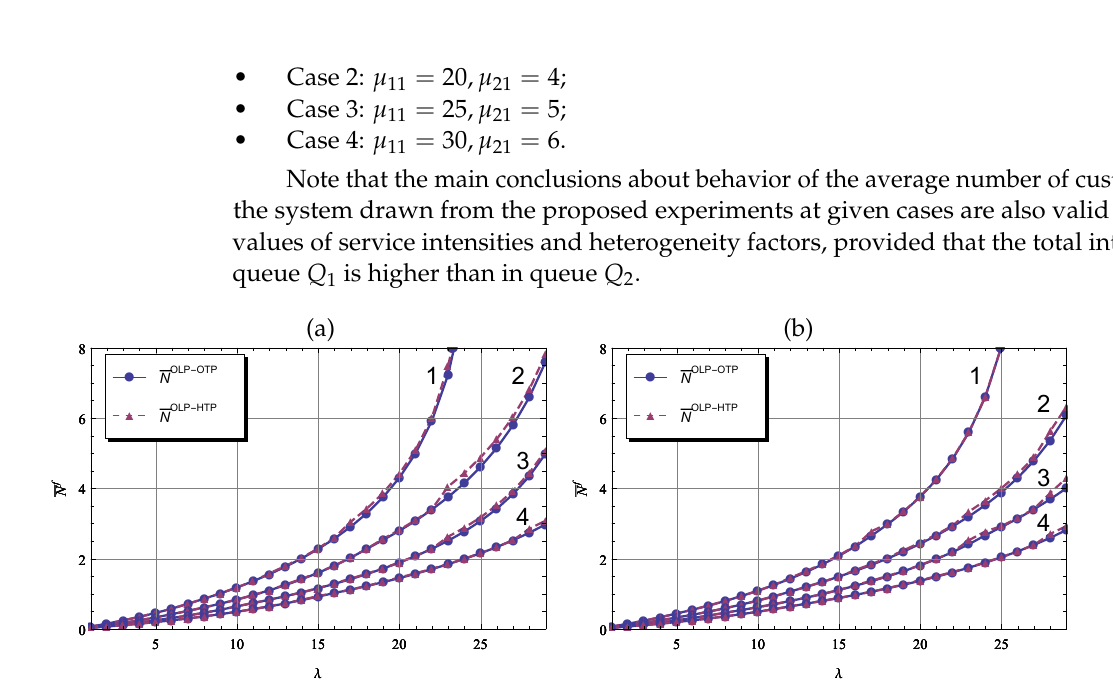
Figure 2. ¯ N f for µ 12 = 10, µ 22 = 2 ( a ) and for µ 12 = 12, µ 22 = 2.4 ( b ) versus λ , µ 11 and µ 21 .